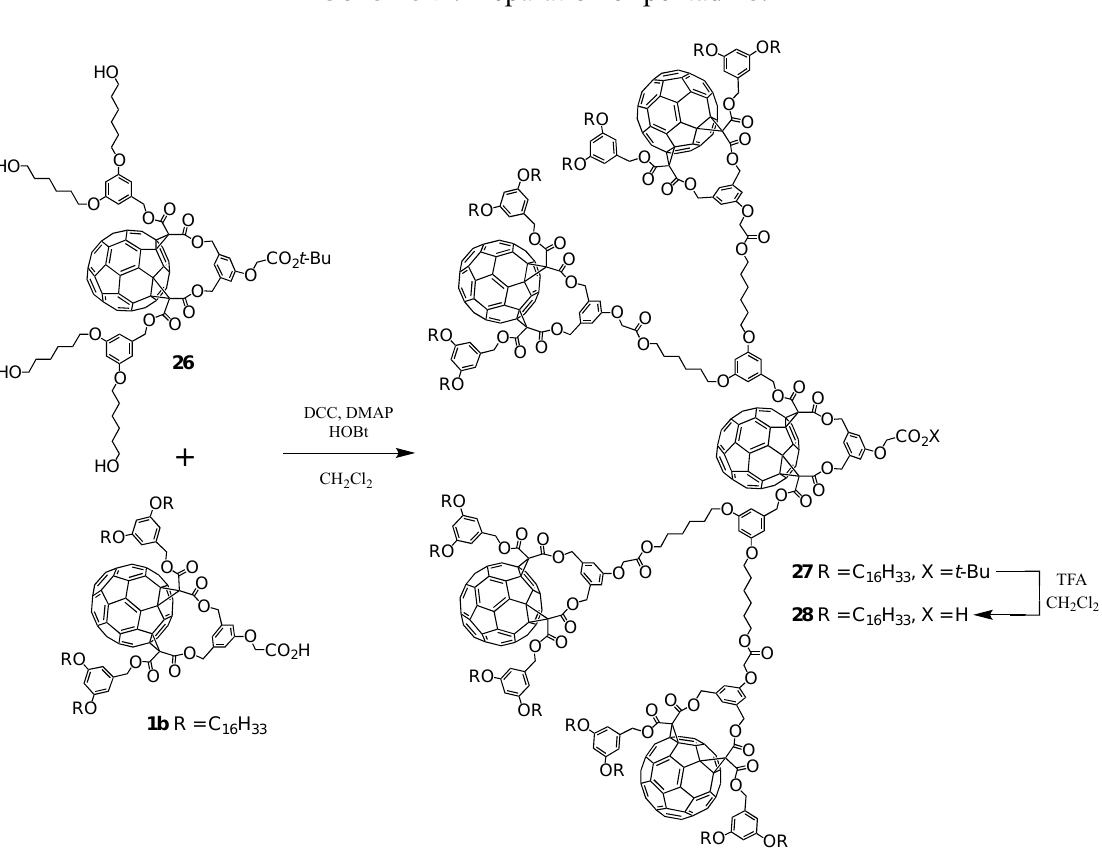
Scheme V. Preparation of pentad 28